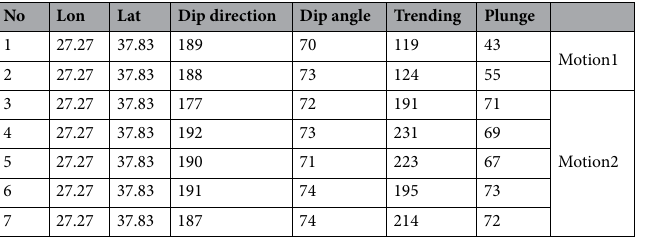
Table 2. Measurements of slickensides and slickenlines on high-angle normal faults of the Yavansu fault.